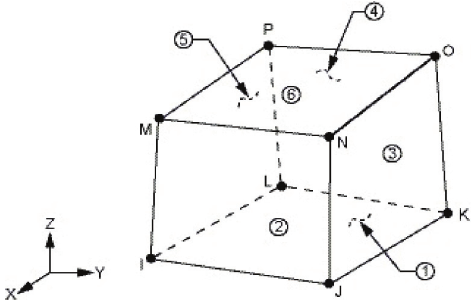
Fig. 1. Solid element Fig. 3. 3-D face of the one-layer laminated